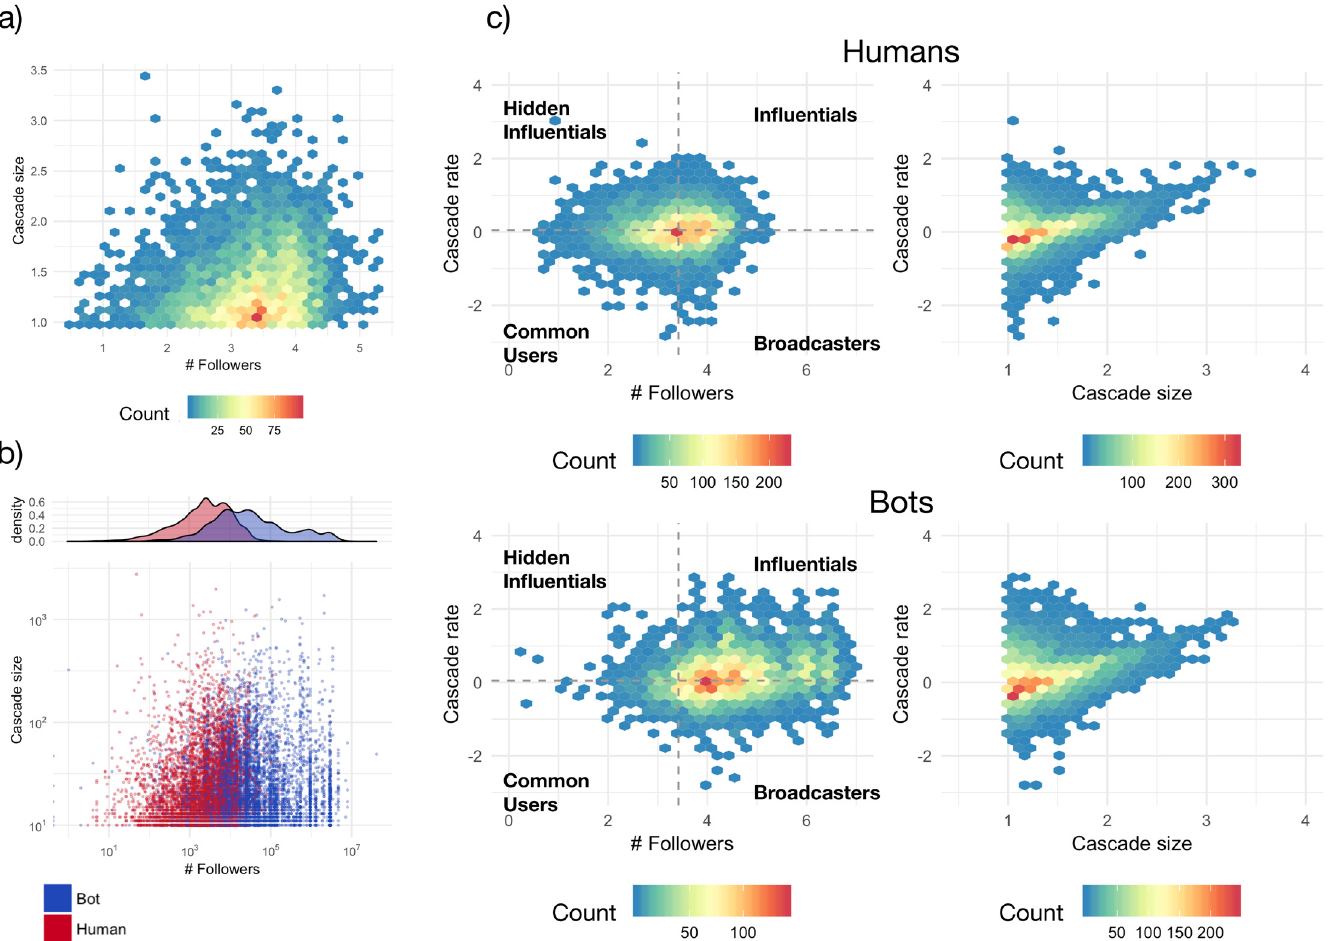
Fig 2. Information cascades during Italian elections. a) Heatmap of the number of users initiating information cascades, as a function of the size of their social neighborhood (Followers) and the size of the generated cascade; b) Scatter plot of the same data, with points encoding users. Color encodes bot/human classification and size encodes cascade’s diameter; c) As in a) but considering cascade rate (in units of retweets/hour), defined by the ratio between cascade size and its duration, vs. neighborhood size (left panels) and cascade size (right panels), for humans (top panels) and bots (bottom panels). The heatmap of cascade rate vs. neighborhood size allows one to identify 4 categories: hidden influentials, influentials, common users and broadcasters (see the text for further detail). Dashed lines indicate medians of structural and dynamical features in humans. Only cascades with at least 10 adopters are considered and, for heatmaps, the logarithm of the corresponding variables is